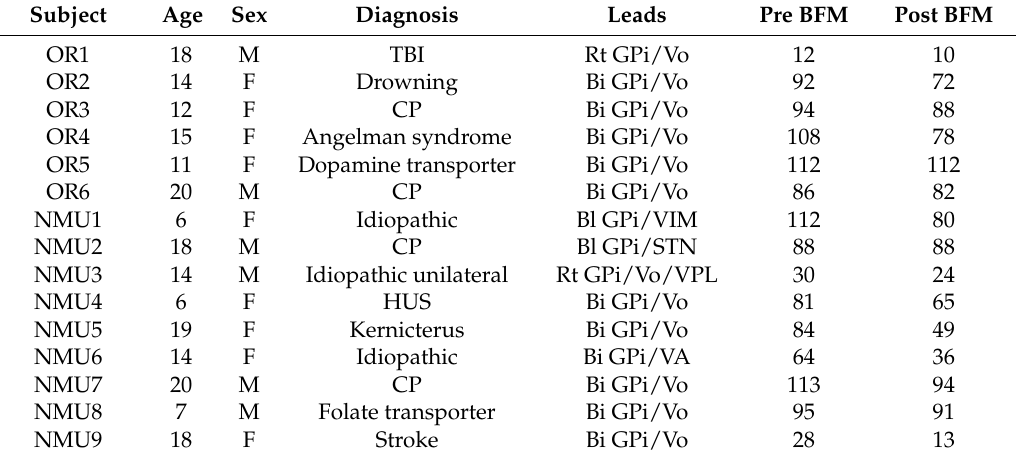
Figure 4. Axial ( a , b ) and coronal ( c , d ) views of the postoperative CT overlaid on the preoperative MRI, showing the lead locations for the Adtech stereo EEG leads. Planned trajectories for permanent leads are shown in color ( b , d ). Data from patient NMU4. Table 1. Demographics and outcomes. Subjects OR1–OR6 had targeting performed in the operating room, while subjects NMU1–NMU9 had targeting performed in the Neuromodulation